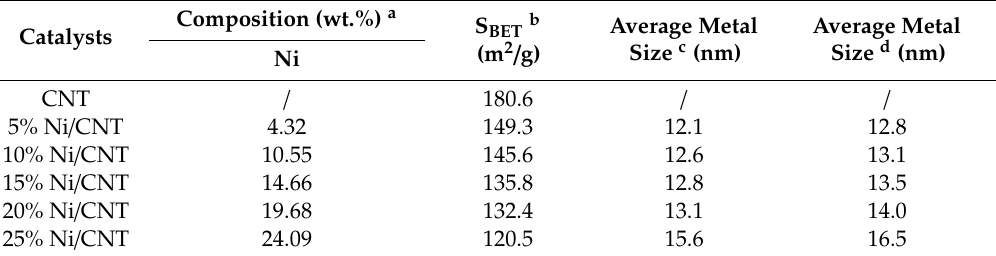
Table 1. Chemical and physical properties of CNT-supported Ni catalysts.